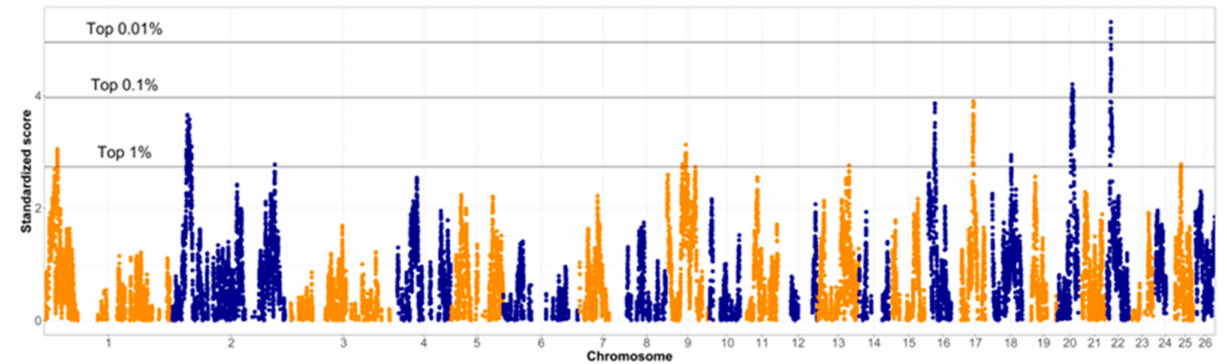
Figure 4. Standardized scores from the varLD indicate selection signatures between the Original and Improved Valachian sheep populations. Horizontal lines indicate highest results in percentage. Alternating colors distinguish markers on neighboring